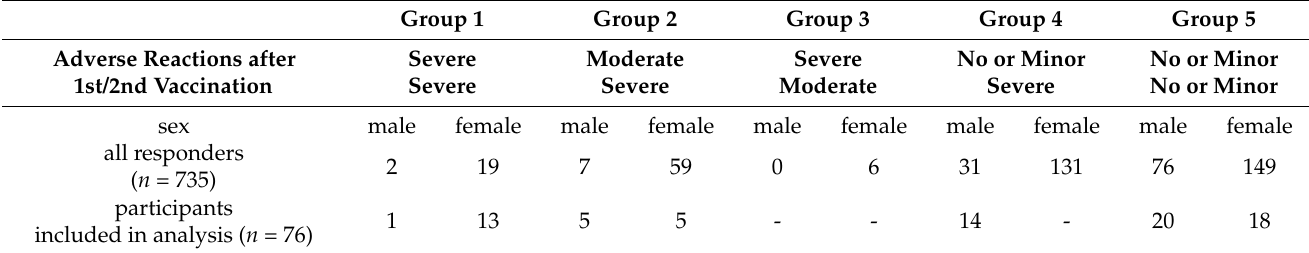
Table 2. Reactogenicity groups relevant for the selection process separated by